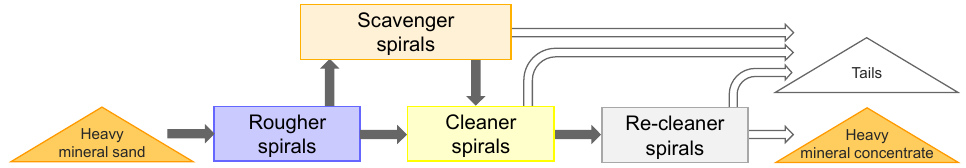
Figure 2. Simplified flow sheet of spiral separation of heavy minerals. The XRD pattern of 46 samples from the four different spiral stages were collected. Without further processing, a cluster analysis was performed on the measurement. The principal component analysis (PCA) score plot in Figure 3 shows four groups of samples. The four clusters represent the four different spirals. The spread of the data points indicates the diversity in the mineralogical phase content in the clusters. Samples from the rougher spirals have a more diverse mineralogical composition compared to the other three clusters. Most similar are the samples coming from the re-cleaner